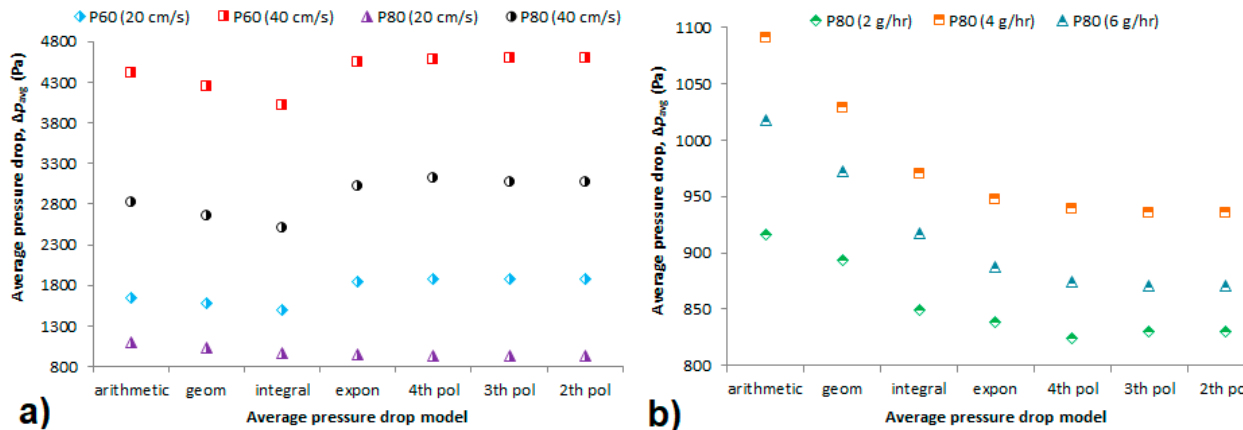
Figure 5. Average pressure drop of different membranes at different permeate velocities at a constant loading rate of 4 g/h ( a ) and P80 membrane at 20 cm/s at different loading rates ( b ).